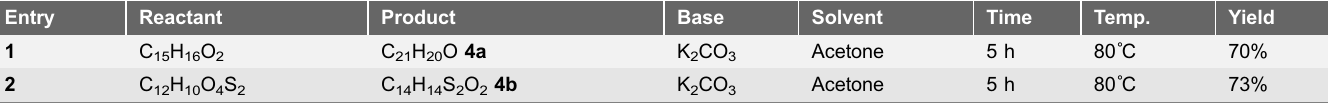
Table 2. Optimization of reaction conditions for compounds 4a–b